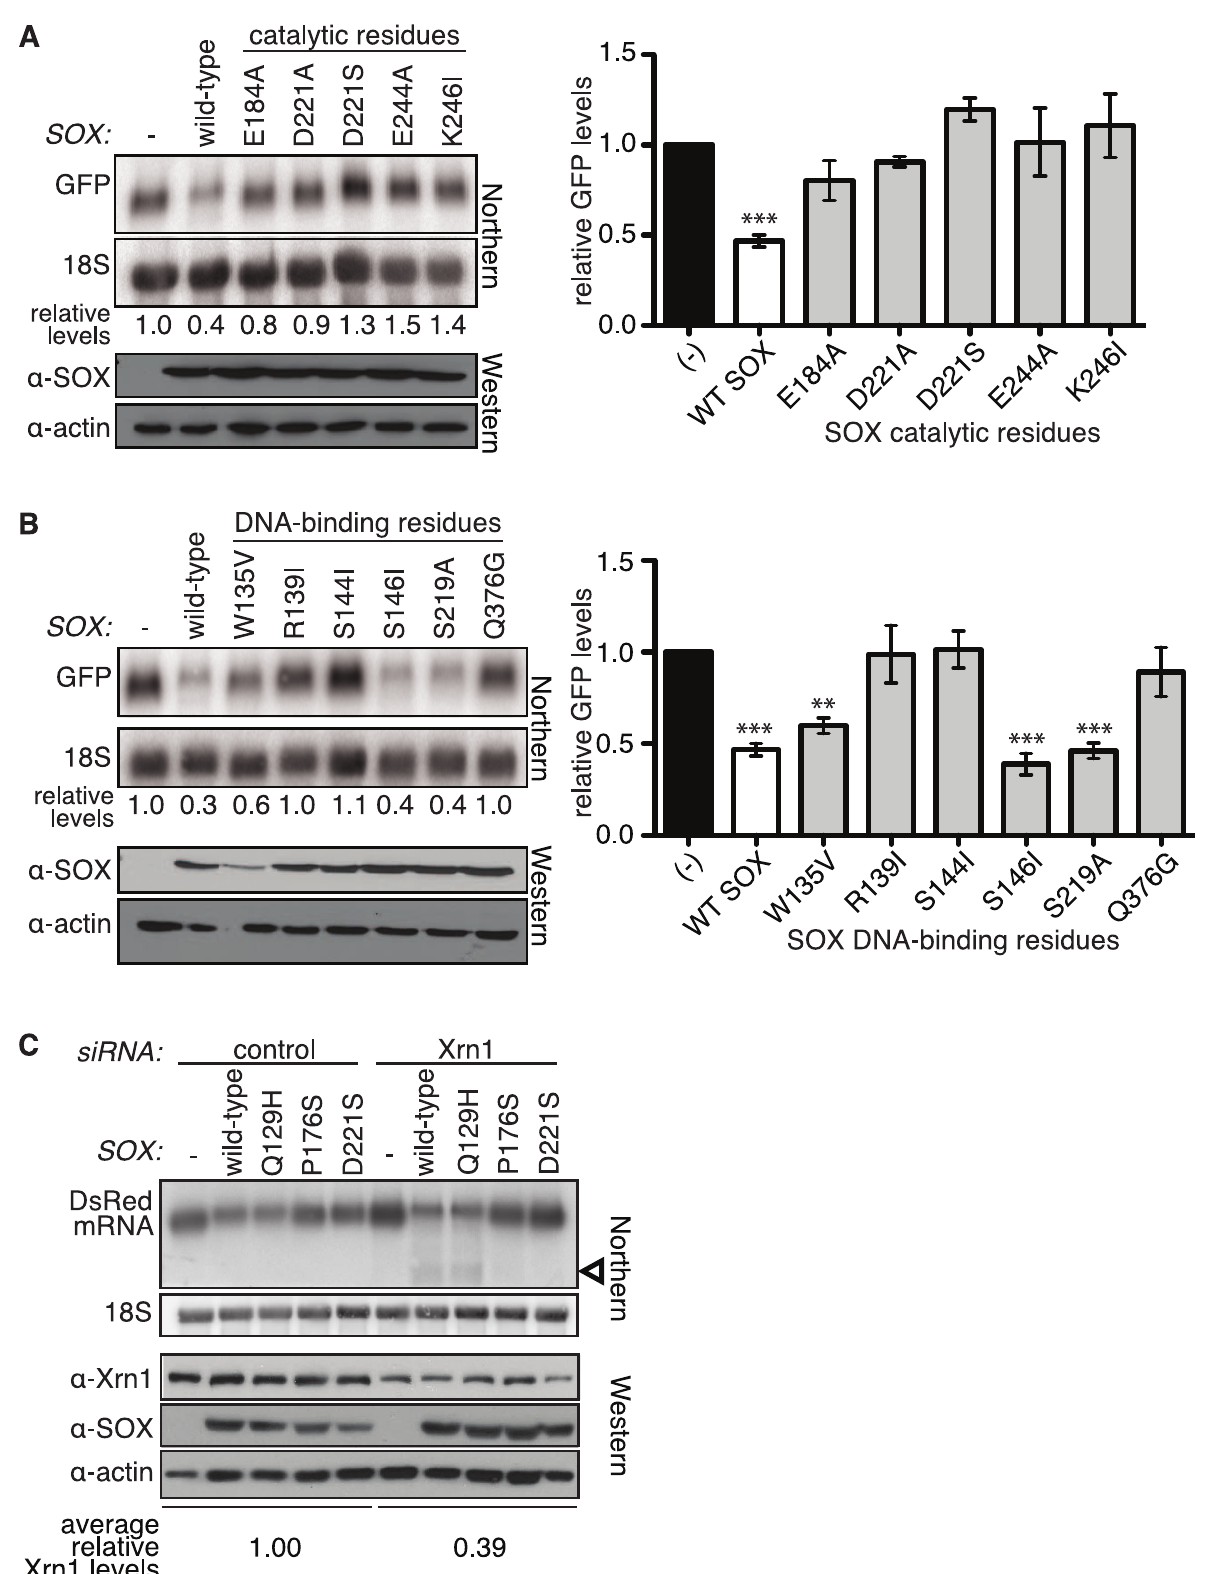
Figure 4. The catalytic residues of SOX are required for mRNA turnover and generation of the degradation intermediate. (A–B) Wild- type (WT) SOX or SOX putative catalytic (A) or DNA binding (B) residue mutants were transfected into 293T cells with a GFP reporter. RNA was Northern blotted using a 5 9 GFP or 18S probe, and protein lysates were Western blotted for SOX and actin (as a loading control). Graphs depicting